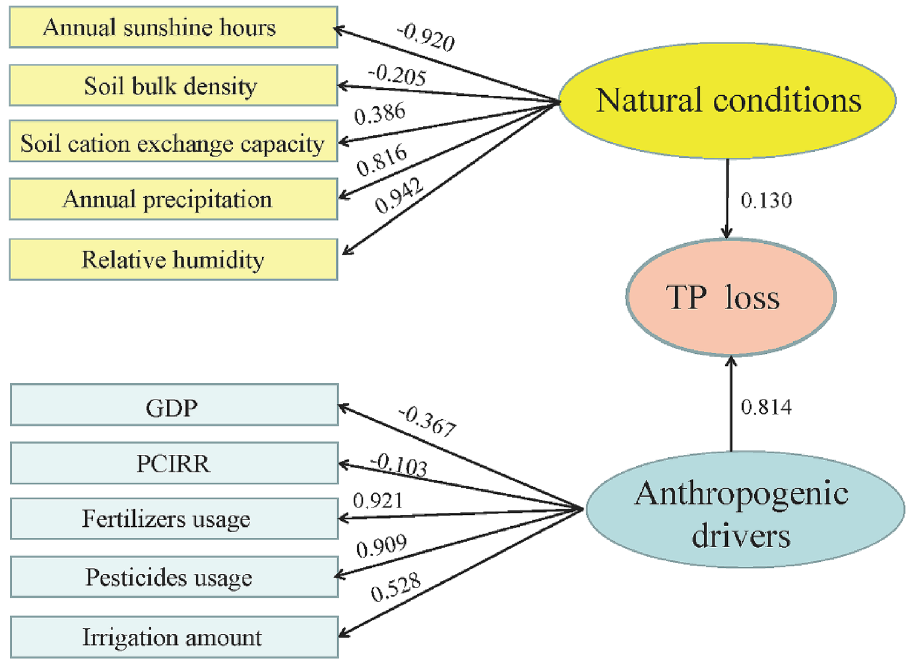
Figure 2. Structural equation model (SEM) illustrating the direct and indirect effects of natural conditions and anthropogenic drivers on TP